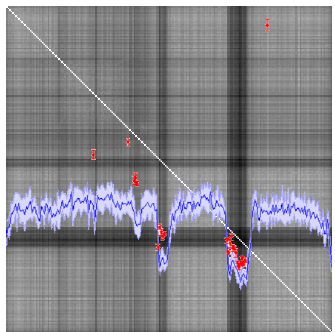
Figure 1: Proposed band selection based on usage frequencies of individual bands in a ProB-RF (red, blue) and correlation be- tween classification maps